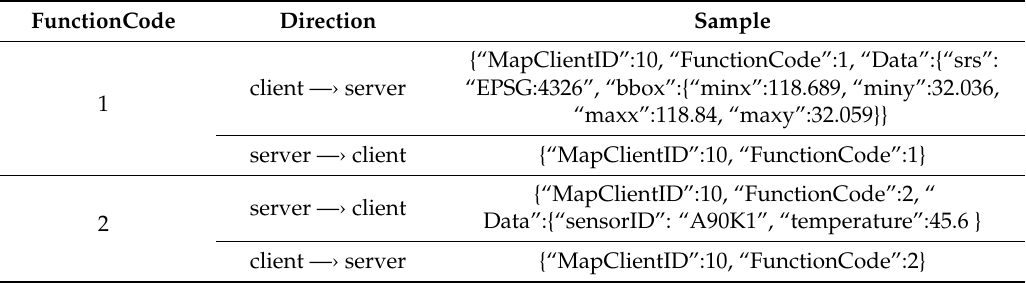
Table 1. Spatial-communication protocol